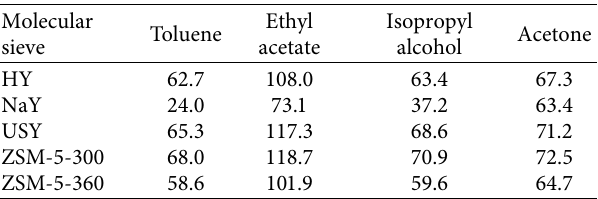
Figure 4: Adsorption breakthrough curve of molecular sieve for ethyl acetate. Note: Airspeed 5000h − 1 . The adsorption conditions are normal pressure, (35 ± 2) ° C, molecular sieve loading 2.0g, toluene and ethyl acetate concentration 500mg/m 3 , and water vapor RH � 60%. Table 1: The saturated adsorption capacity of VOCs adsorbed by molecular sieves (mg/g).